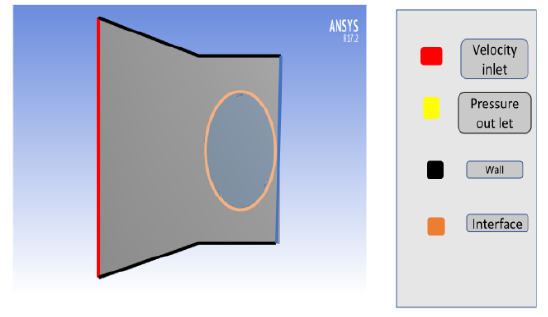
Fig. 2. 2D Geometries of convergent duct.